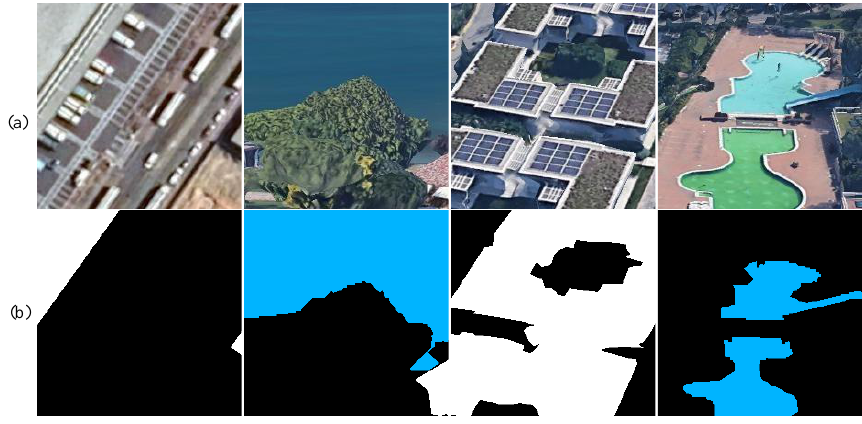
Figure 7. Land segmentation dataset. ( a ) Original image; ( b ) artificial label. To facilitate the experiments, all pictures were cut in a certain order—from left to right and from top to bottom, and there was no area overlap during the segmentation; images with only one category were excluded to obtain a final dataset of more than 12,000 images (224 × 224 px). The dataset is randomly divided into a training set and a test set at a ratio of